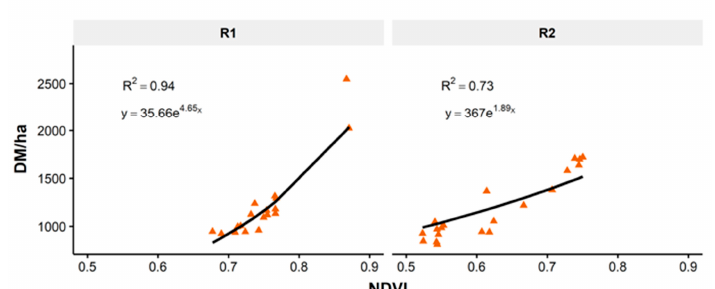
Figure 3. Calibration equations of compressed height into pasture biomass (kg DM / ha) for the electronic rising plate meter ( ● , — ) and normalized difference vegetation index (NDVI) into pasture biomass for Planet satellite ( ■ ; — ) and Sentinel satellite ( ▲ ; — ), for regrowth periods 1 and 2 (R1 and R2, respectively).